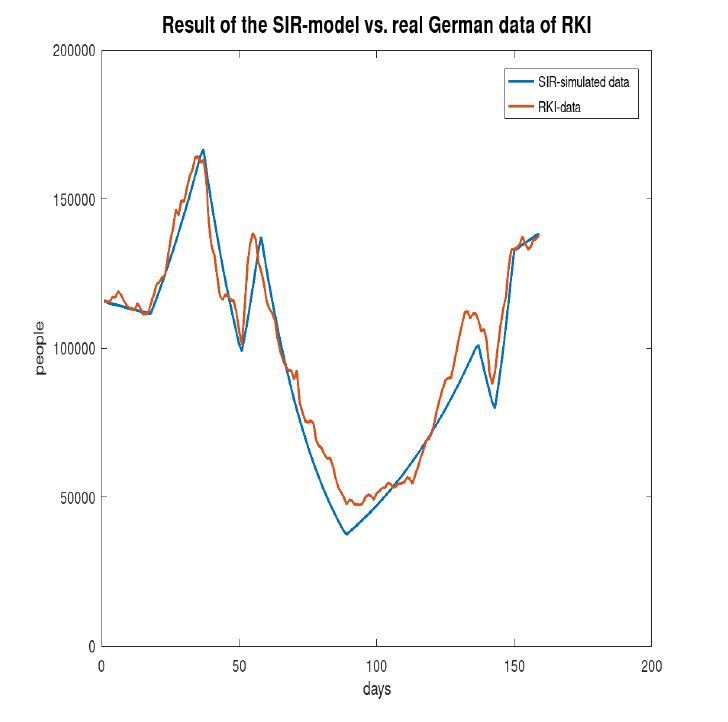
Figure 6. Comparison of real data [8] and simulation